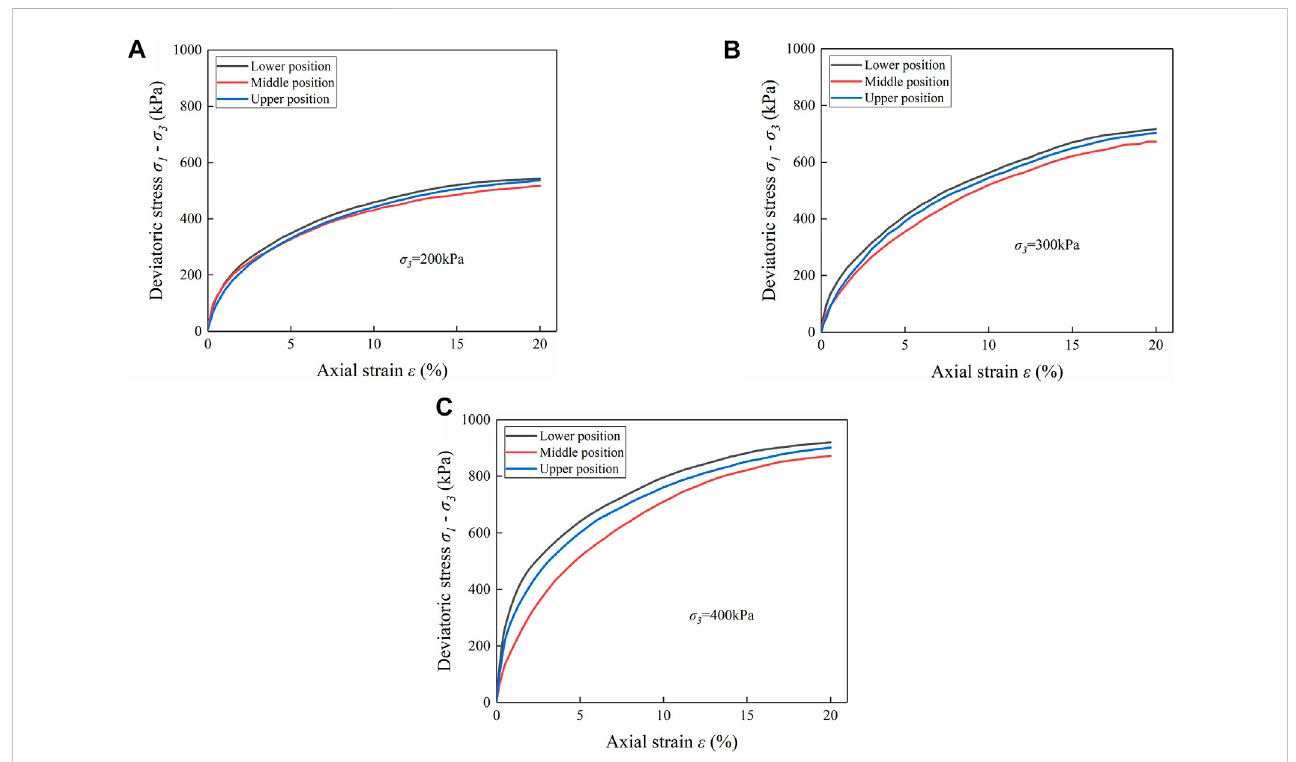
FIGURE 5 Deviator stress versus axial strain of loess with different fractured positions: (A) σ 3 =200 kPa; (B) σ 3 =300 kPa; (C) σ 3 =400